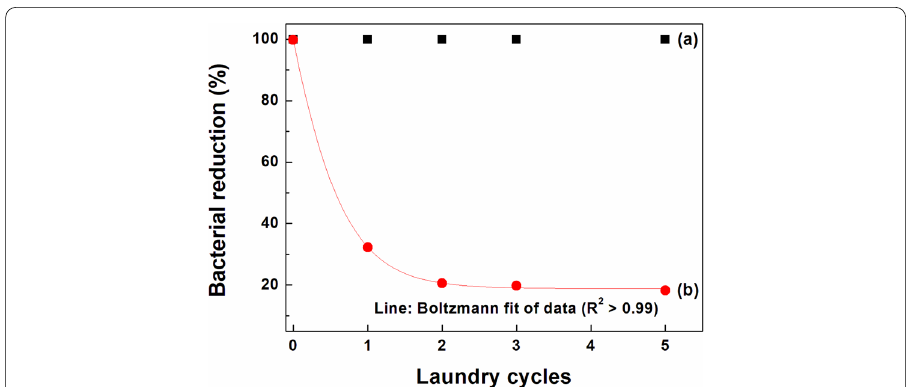
Fig. 6 Antimicrobial capacity of gallotannin-printed cotton fabrics with increasing laundering cycles: a against S. aureus , b against K.